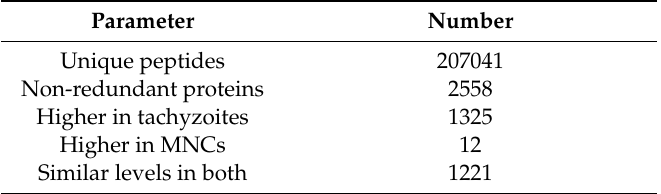
Table 2. Summary of protein quantification data. N. caninum tachyzoites and MNCs were grown, purified and subjected to MS shotgun analysis as described in the Materials and Methods. For each group, three biological replicates have been tested (with 2 technical replicates per biological